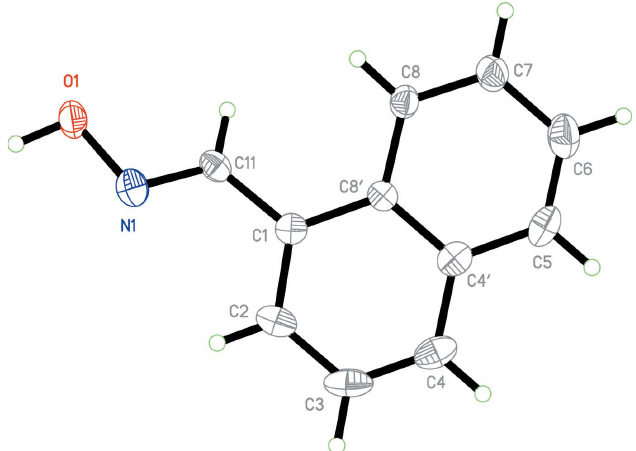
Figure 1 The molecular conformation and atom-numbering scheme for (I), with non-H atoms represented as 30% probability ellipsoids.